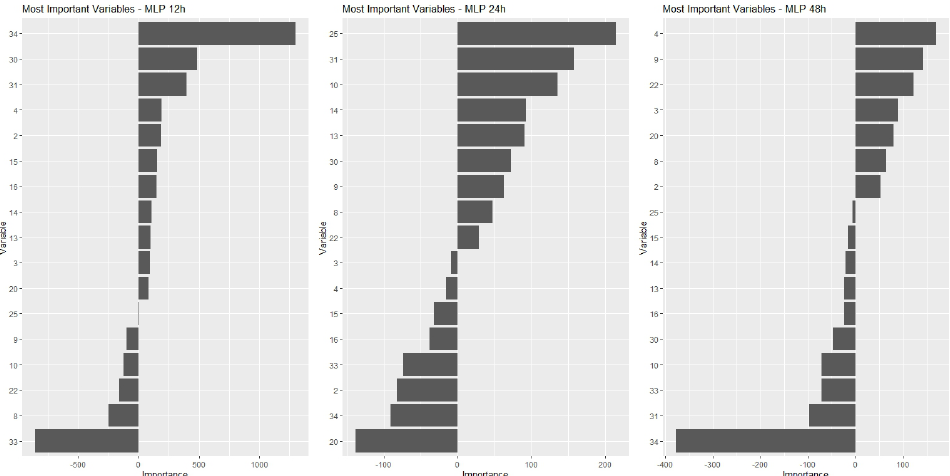
Figure 4. Most Important Variables for DT—Decision Tree Models.